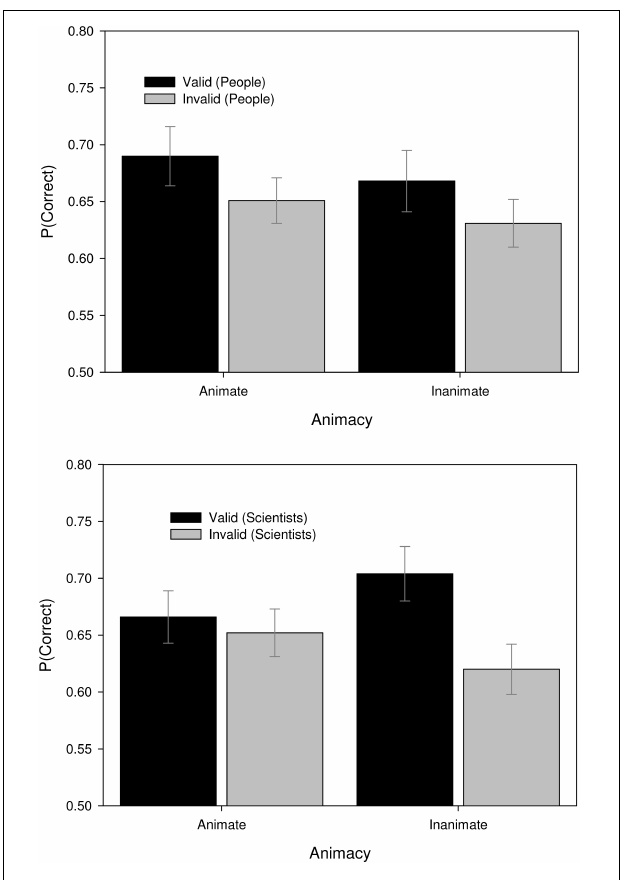
FIGURE 1 | Proportion correct for explanations of animate and inanimate provided by people (top) and scientists (bottom) . Error bars represent standard error of the mean.